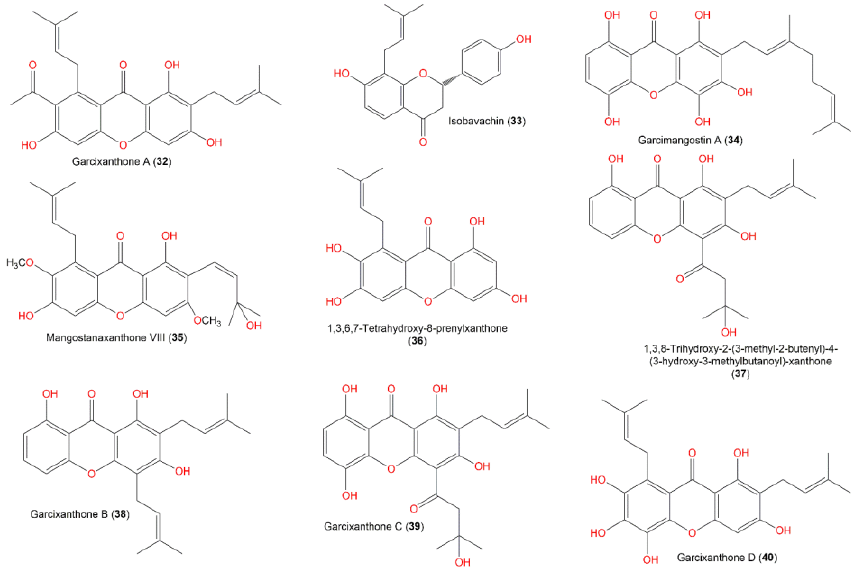
Figure 4. Structures of compounds 32 – 40 .